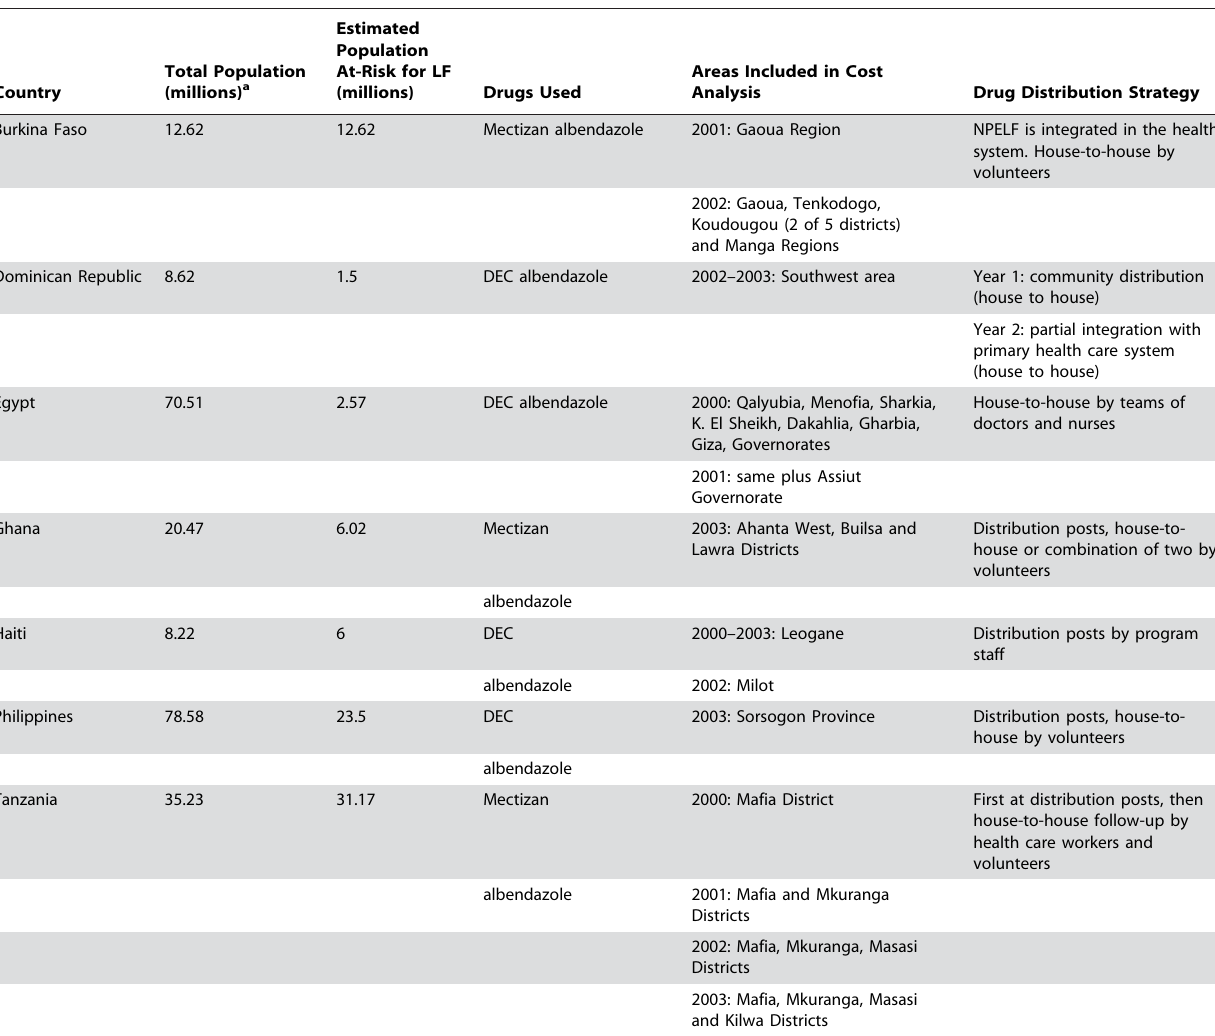
Table 3. Country Background Information.